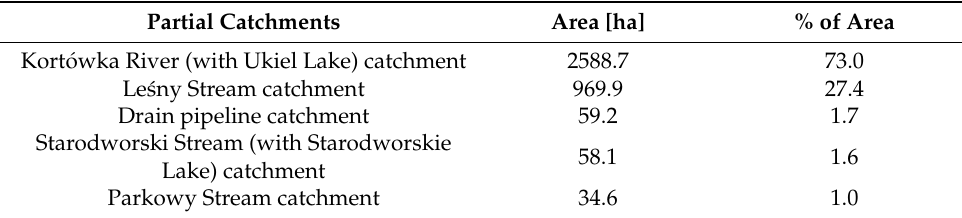
Table 2. Partial catchment areas of Lake Kortowskie drainage basin